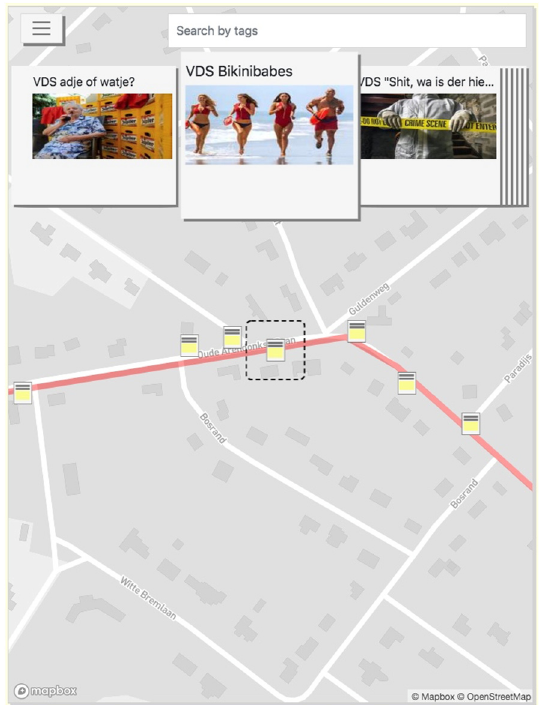
Figure 11. TICKLE’s card interface for the second evaluation with VDS.